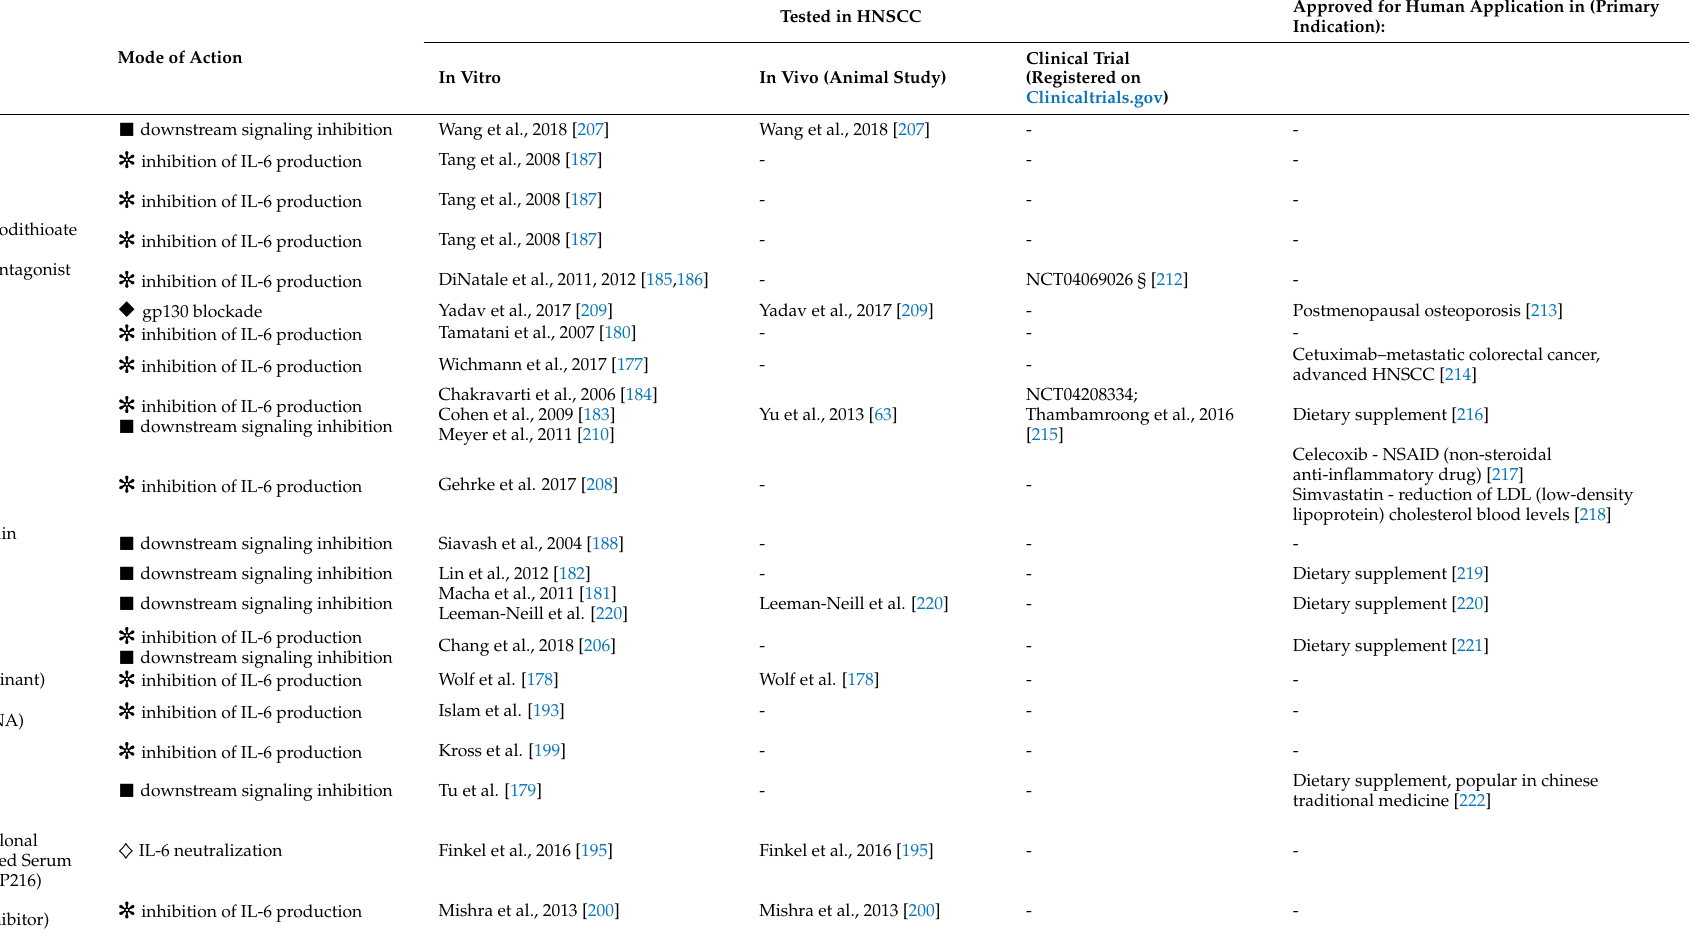
Table 1. List of recently tested anti-IL-6